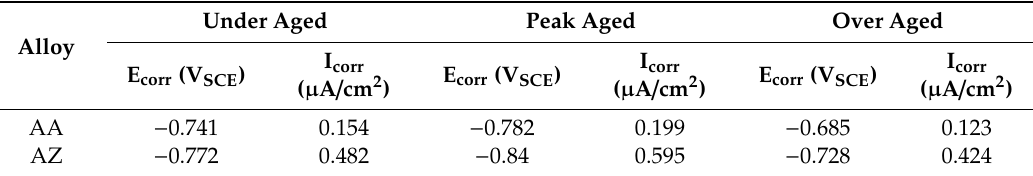
Figure 10. Potentiodynamic polarization curves of alloy AA and AZ under different aging conditions at 170 °C: ( a ) under aged, ( b ) peak aged, and ( c ) over aged. Table 6. E corr , I corr of alloy AA and AZ under different aging conditions at 170 °C